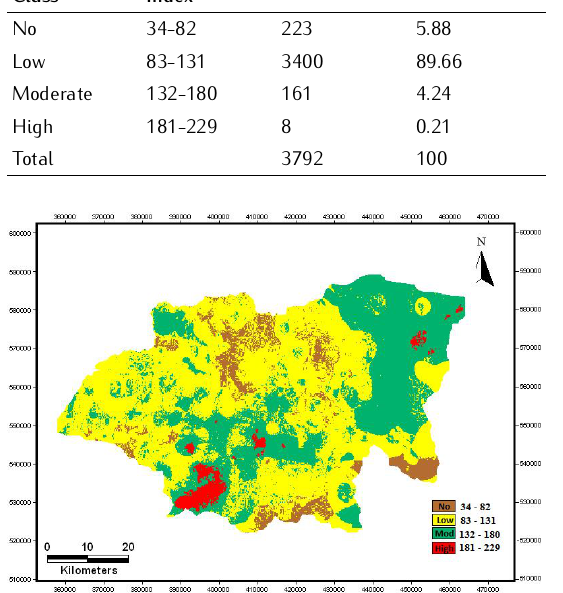
Figure 13. The final modified DRASTIC vulnerability index map of groundwater in